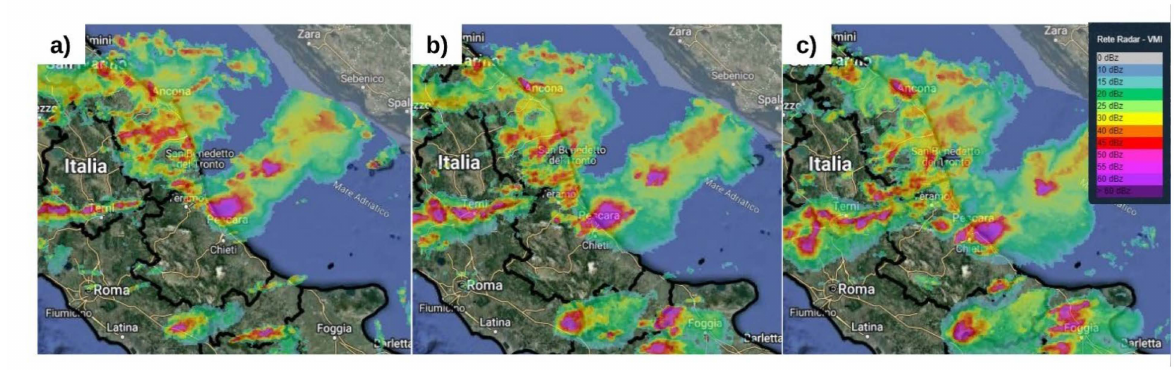
Figure 2. Composite radar VMI at 10:00 ( a ), 10:30 ( b ), and 10:55 UTC ( c ), 10 July 2019. The images are retrieved from the Italian Radar Network data.